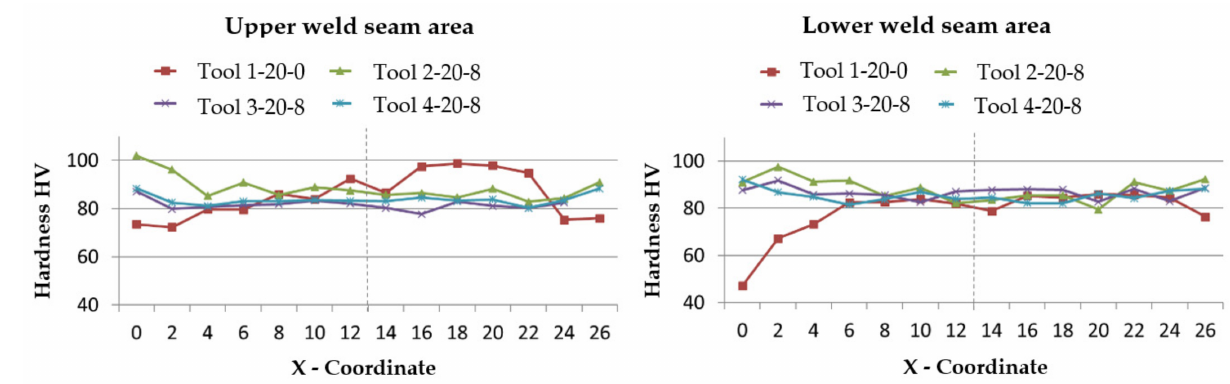
Figure 17. Hardness profiles over the welding seam for welds with 0.9 mm joint gap for material EN AW 5083